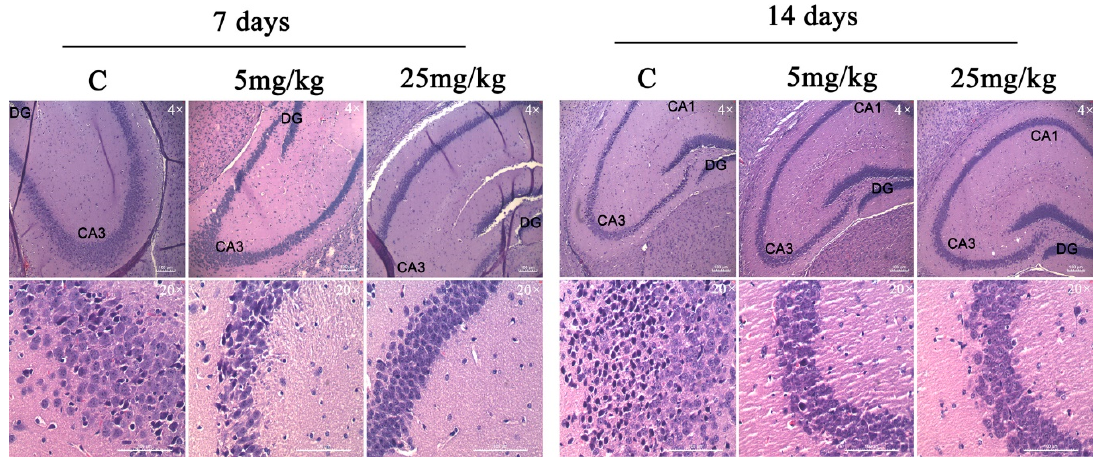
Figure 7. D2AAK1-mediated changes in hippocampus. The compound was administered for 7 and 14 days and histological slides were analyzed. Magnification of the objective lens 4× and 20×.